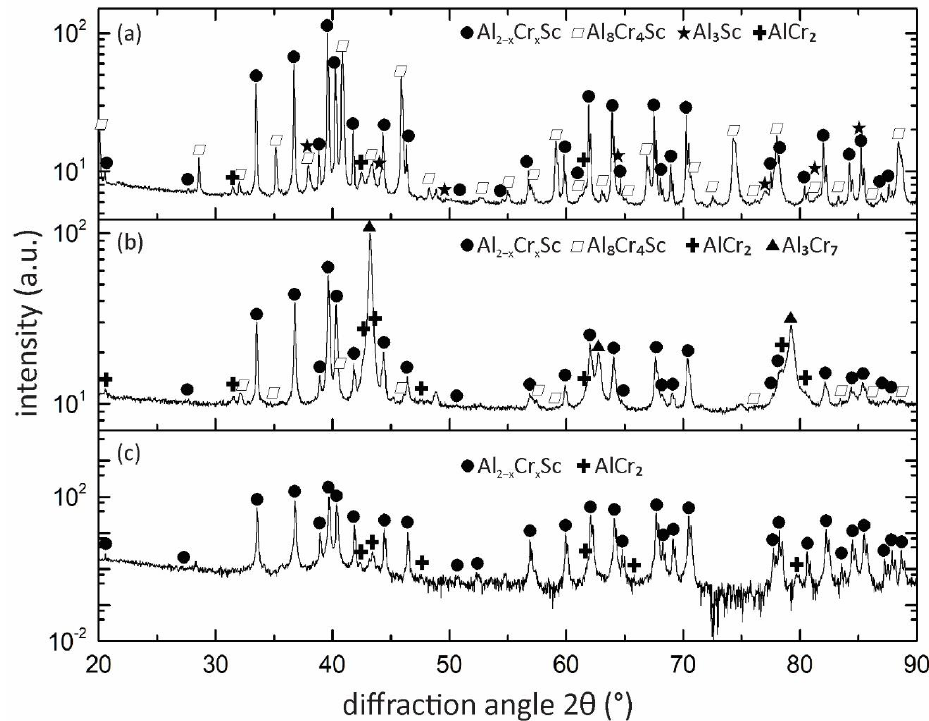
Figure 2. PXRD patterns of ( a ) sample I, ( b ) sample II and ( c ) sample III after being annealed at 990 °C for 240 h. Each phase is denoted with a different symbol as specified in the insert.